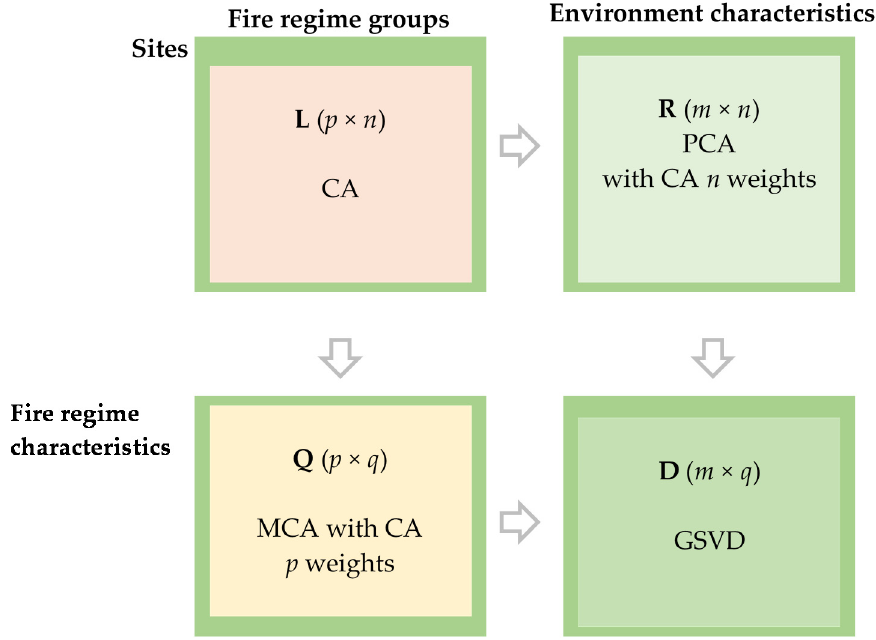
Figure 2. Graphical representation of the RLQ analysis. Matrix L represents the p = 4 fire regime groups at n = 4652 sites and was analysed using correspondence analysis (CA). Matrix Q represents the q = 2 fire regime characteristics for each p fire regime group and was analysed using multiple correspondence analysis (MCA) with CA p weights . Matrix R represents the m = 20 environment characteristics for each n site and was analysed by principal component analysis (PCA) with CA n weights. Matrix D represents the fire regime characteristics ‐ environment relationship and was analysed by a generalized singular value decomposition